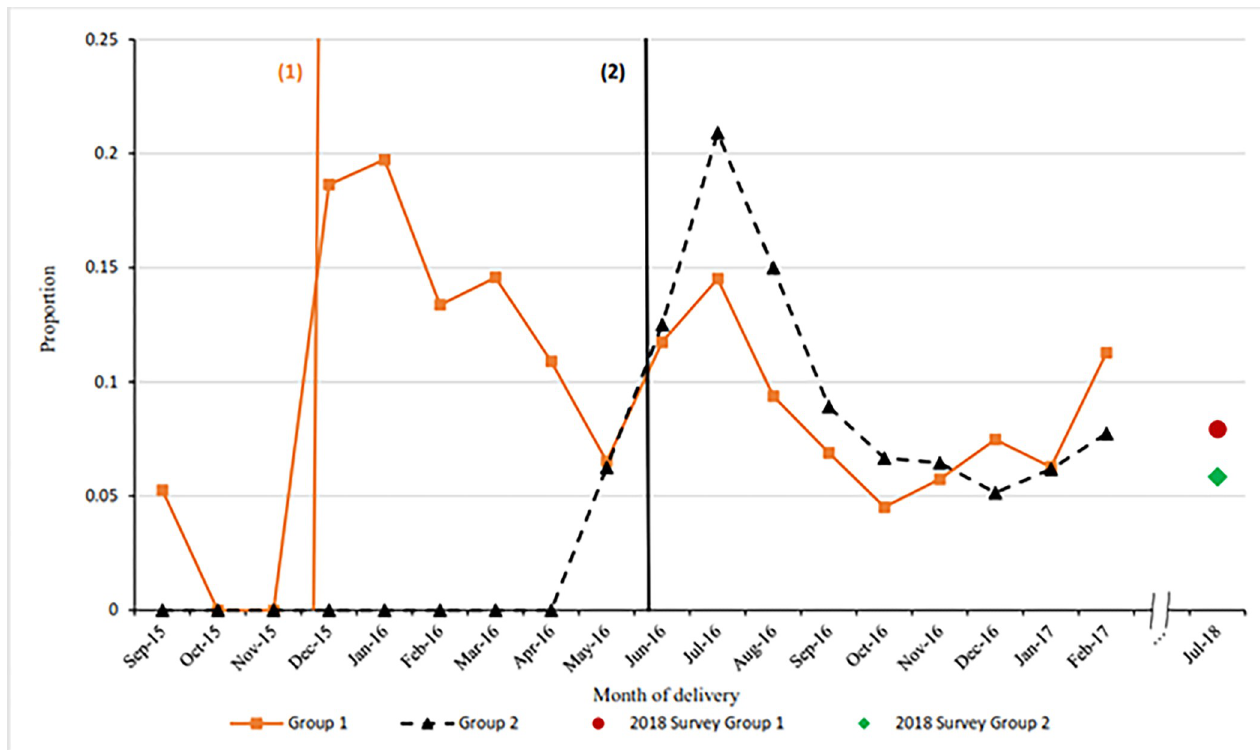
Fig 4. Proportion of women having a PPIUD inserted among those counselled on PPIUD classified by month of delivery in Nepal.